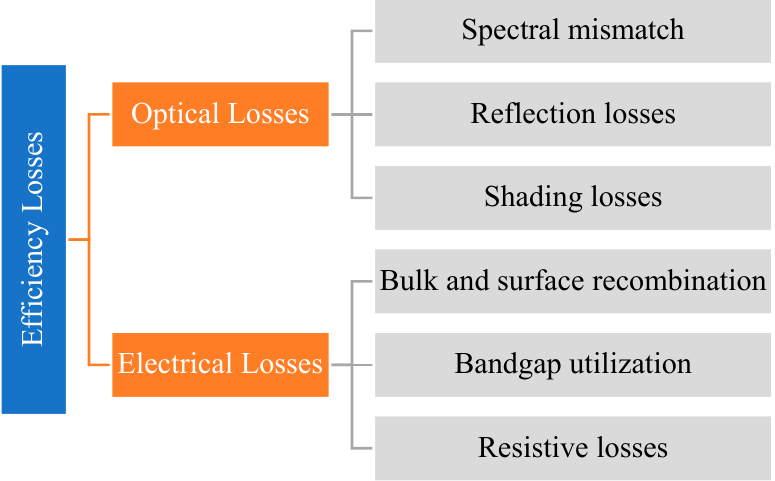
Figure 6. The TPV cells conversion efficiency losses.